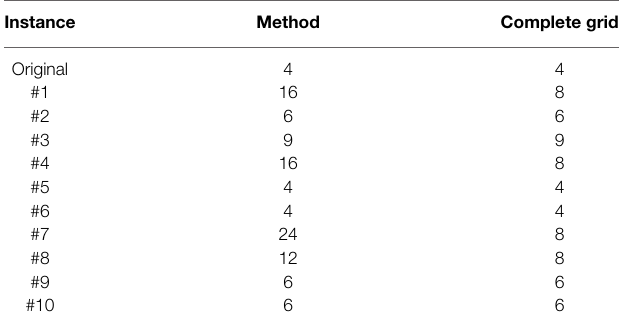
FIGURE 8 | Normalized accuracy measure ∆ TAC divided by total annualized cost of the aggregated synthesis problem TAC *( P ′ ) in percent as numbers in the cells and color code. The path of the iterative method is indicated with bold numbers.